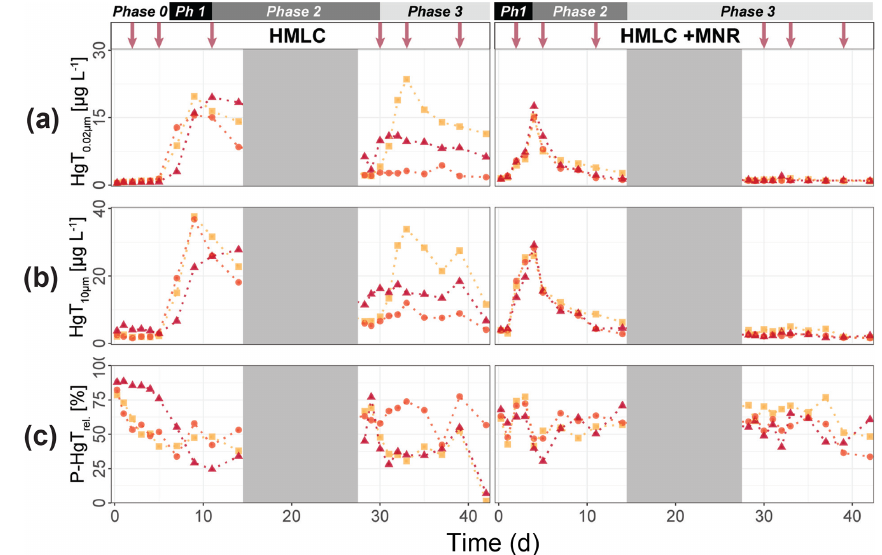
Figure 3. Soil solution dynamics in cornfield soil (HMLC) incubations for Hg (a–c) subdivided into phases (0–3). Lines between points were plotted to improve readability. The gray area indicates the drained period. Red arrows indicate sampling days for AF4–ICP–MS analyses.